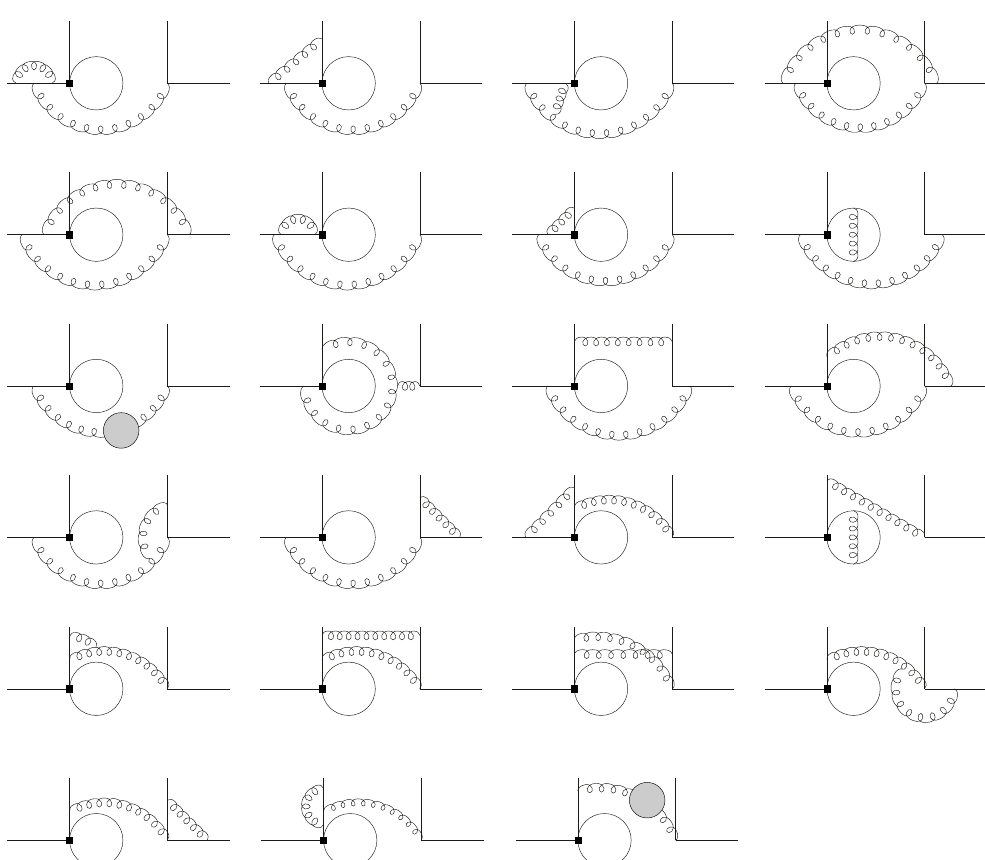
Figure 5 . Two-loop penguin diagrams II. The sum of these diagrams vanishes for all operator